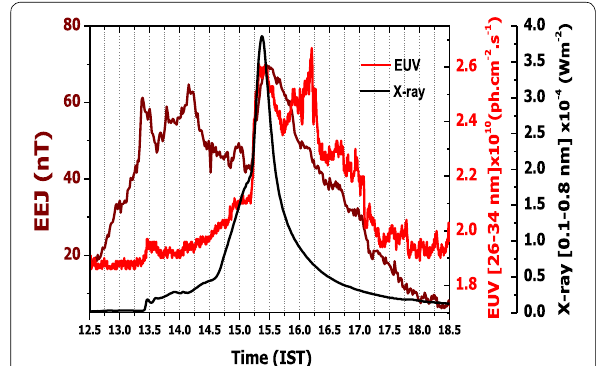
Fig. 1 The daytime variation of the X-ray and EUV flux along with